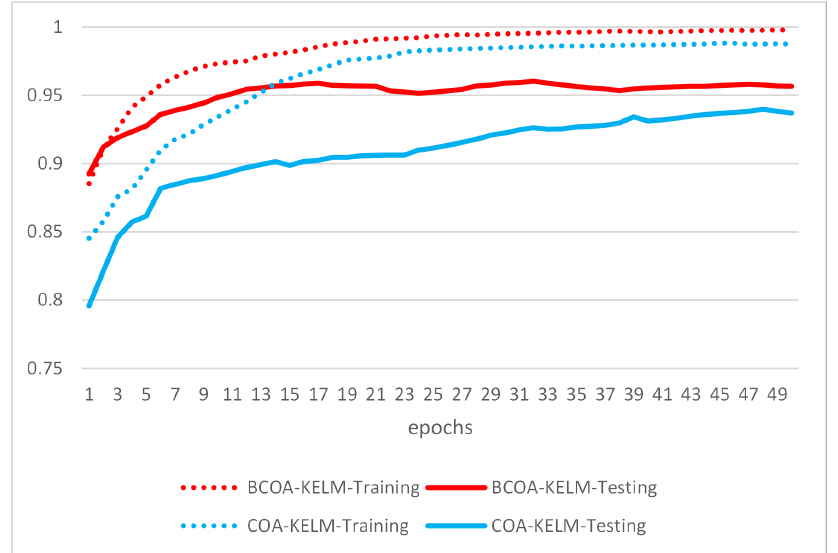
Figure 1. Change of testing ACR with the number of training